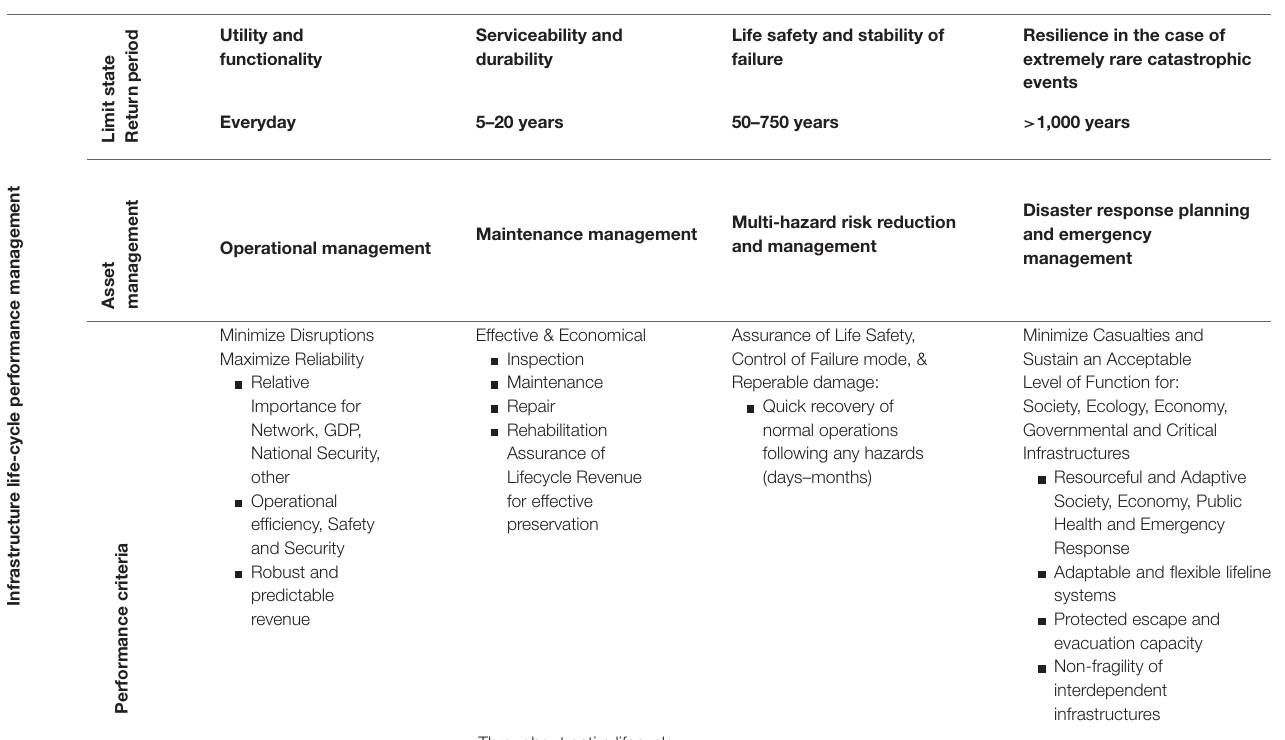
TABLE 1 | Infrastructure life-cycle performance